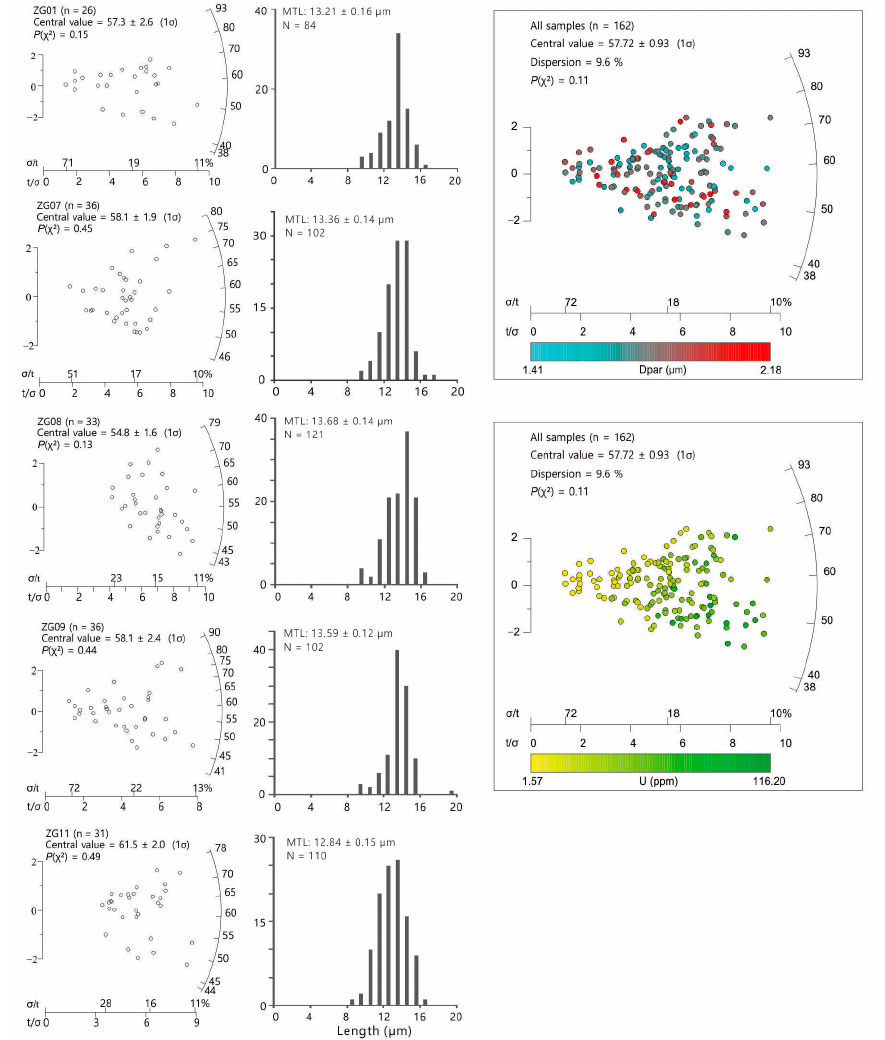
Figure 4. Radial plots of single-grain apatite fission track ages and confined fission track length distributions for Lujing uranium ore field samples. Right-hand images show radial plots for ages versus Dpar and U content. Radial plots were created with RadialPlotter [55]. MTL = mean track length, n = number of apatite grains, N = number of track lengths measured.